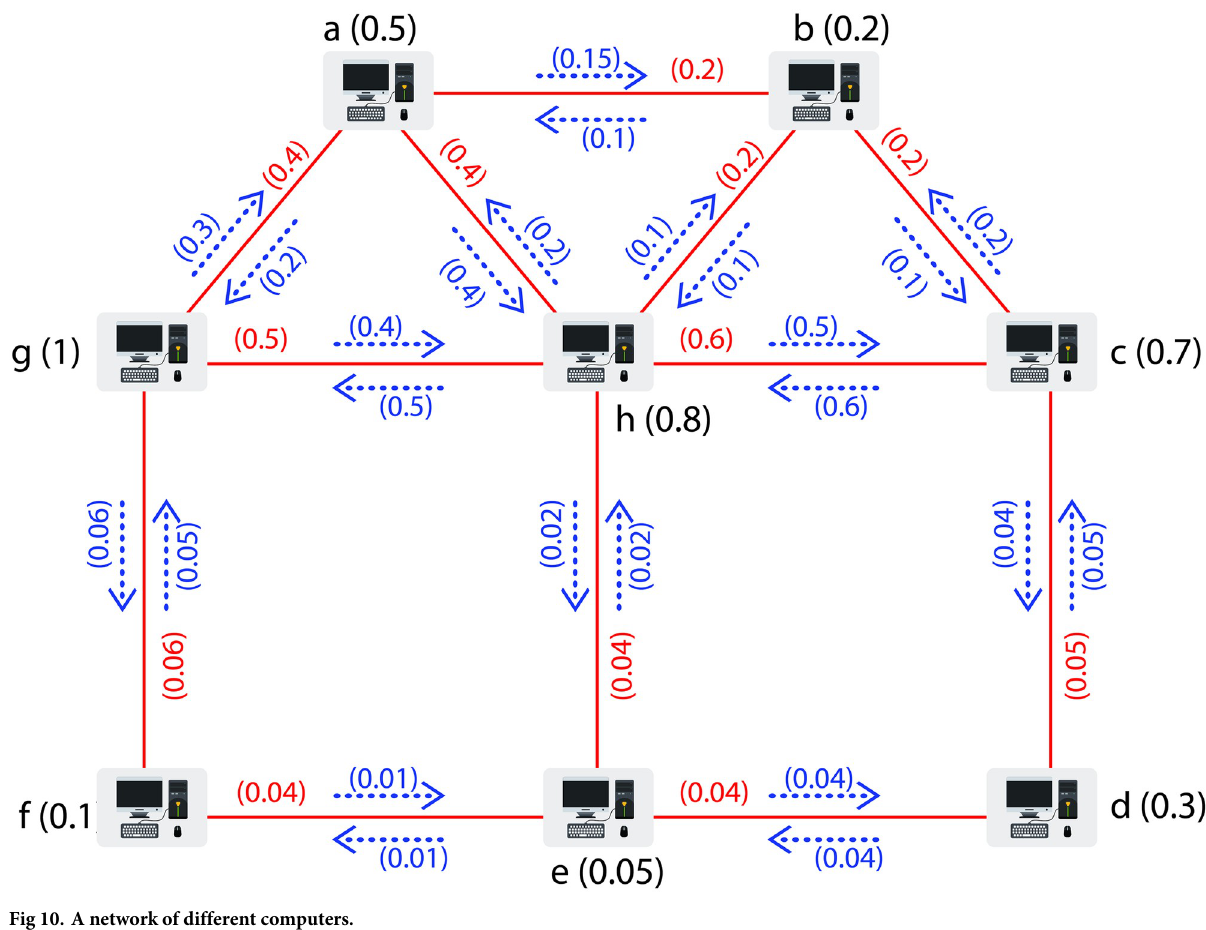
Fig 10. A network of different